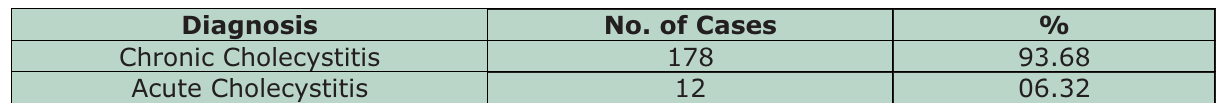
Table-IV: Histopathology (n=